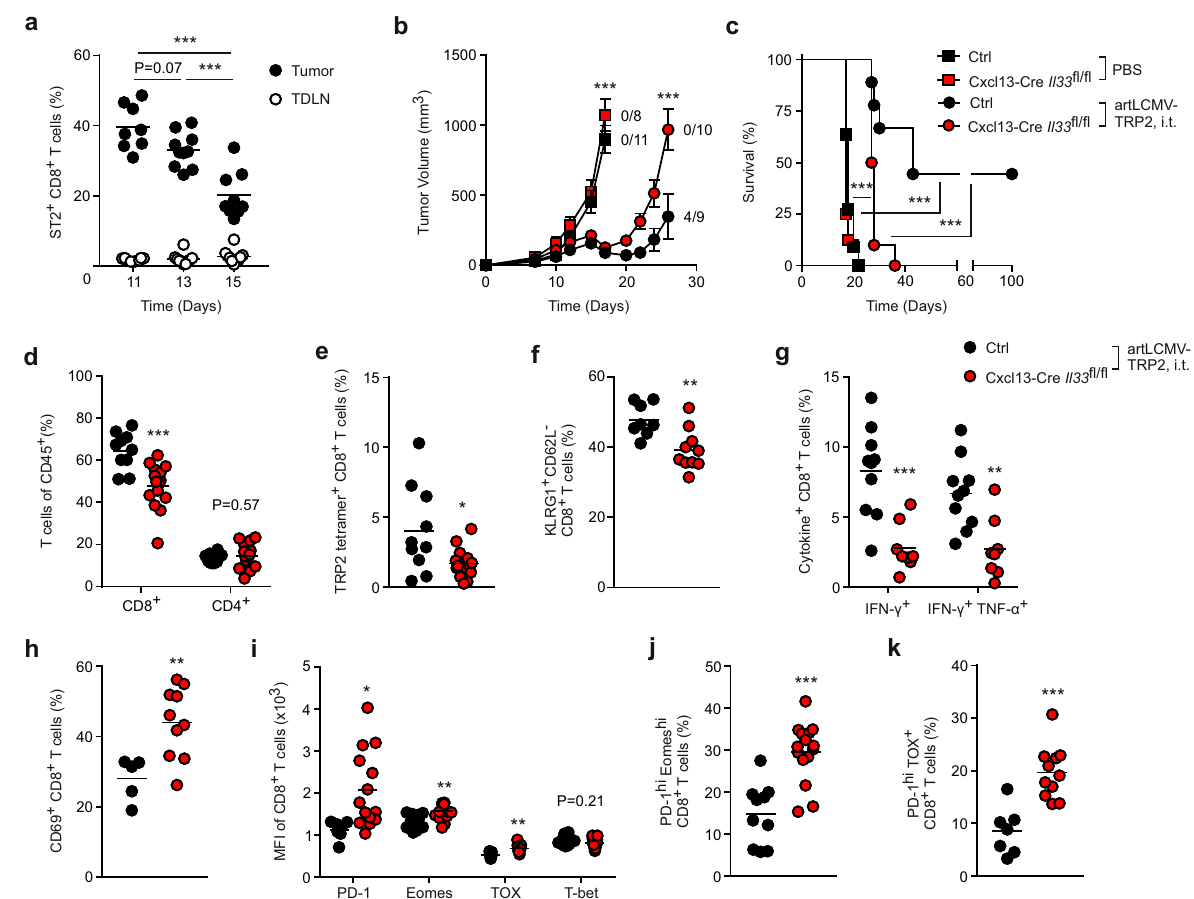
Fig. 6 Sustenance of antitumor T cell responses by FSC-derived IL-33. a Mice were inoculated s.c. with B16F10 melanoma cells and treated on day 7 i.t. with artLCMV-TRP2. Frequency of ST2 + CD8 + T cells in the tumor and the TDLN at indicated time points. b Tumor growth kinetics and c survival in Cxcl13-Cre Il33 fl / fl and Cre-negative littermate mice (Ctrl) treated i.t. with artLCMV-TRP2 on day 7 after B16F10 inoculation. Dots indicate mean ± s.e.m. for each time point. d – k Tumor-in fi ltrating T cells were analyzed by fl ow cytometry on day 15. d Frequency of tumor-in fi ltrating CD8 + and CD4 + T cells. e Frequency of TRP2 tetramer + CD8 + T cells and f KLRG1 + CD62L − CD8 + T cells. g IFN- γ - and TNF- α -producing tumor-in fi ltrating TRP2-speci fi c CD8 + T cells. h Frequency of CD69 + CD8 + T cells. i Mean expression of Eomes, PD-1, TOX, and T-bet on tumor-in fi ltrating CD8 + T cells and j Frequency of PD- 1 hi Eomes hi and k PD-1 hi TOX + among CD8 + T cells. Dots represent individual mice and lines indicate mean values. Pooled data from two independent experiments with n = 8 (Day 11), n = 10 (Day 13) and n = 9 (Day 15) ( a ); n = 11 (PBS, Ctrl), n = 8 (PBS, Cxcl13-Cre Il33 fl / fl ), n = 9 (artLCMV-TRP2, i.t., Ctrl) and n = 10 (artLCMV-TRP2, i.t., Cxcl13-Cre Il33 fl / fl ) mice ( b , c ); n = 8 (Ctrl) and n = 10 (Cxcl13-Cre Il33 fl / fl ) mice ( f ); n = 10 (Ctrl) and n = 8 (Cxcl13-Cre Il33 fl / fl ) mice ( g ); n = 5 (Ctrl) and n = 10 (Cxcl13-Cre Il33 fl / fl ) mice ( h ); n = 7 (TOX, Ctrl) and n = 9 (TOX, Cxcl13-Cre Il33 fl / fl ) mice ( i ); n = 7 (Ctrl) and n